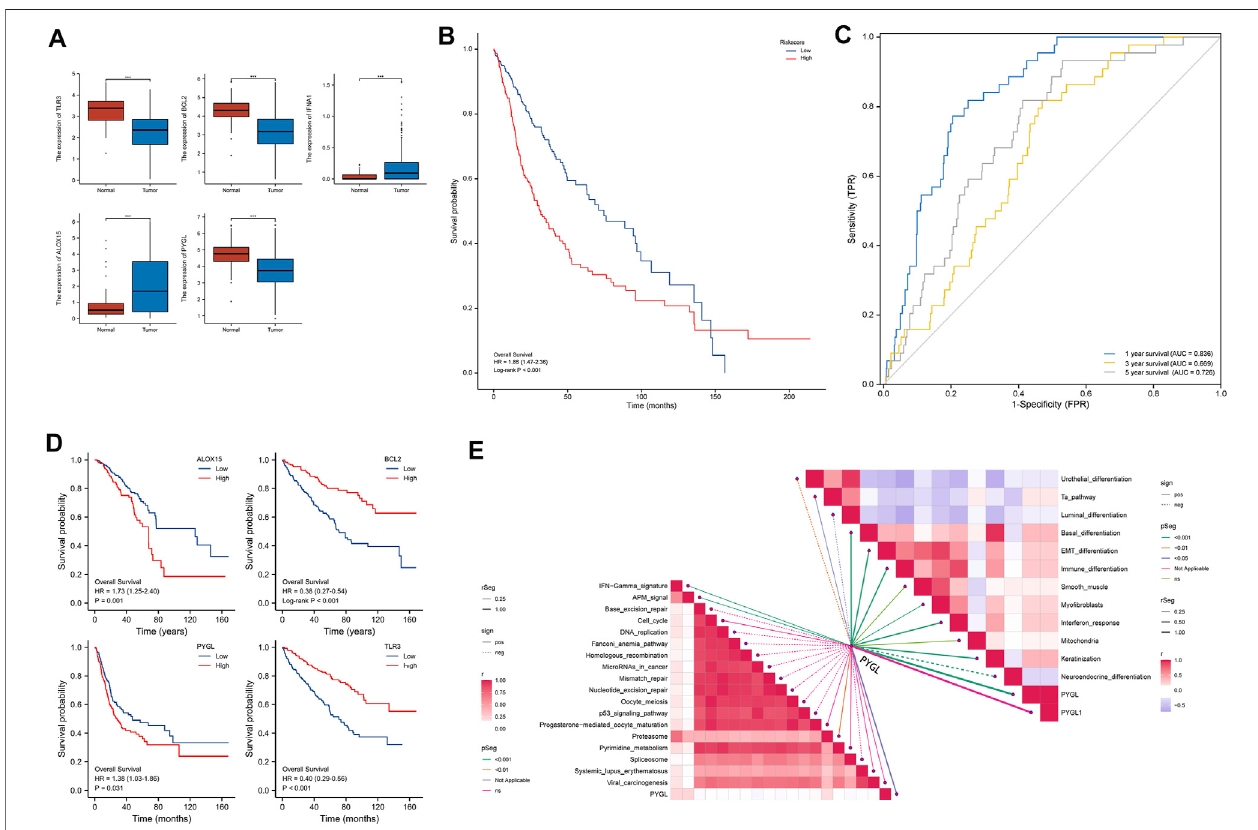
FIGURE 4 | Validation of the 5-gene signature using a validation cohort. (A) . Results of qRT-PCR analysis. (B) . Kaplan-Meier curves showing OS of patients in the high-risk and low-risk groups. (C) . AUCs of time-dependent ROC curves indicating the prognostic performance of the risk score. (D) . Kaplan-Meier curves showing OS of patients in the high- and low-expression groups of 5 DEGs. (E) Pathway analysis targeting PYGL.